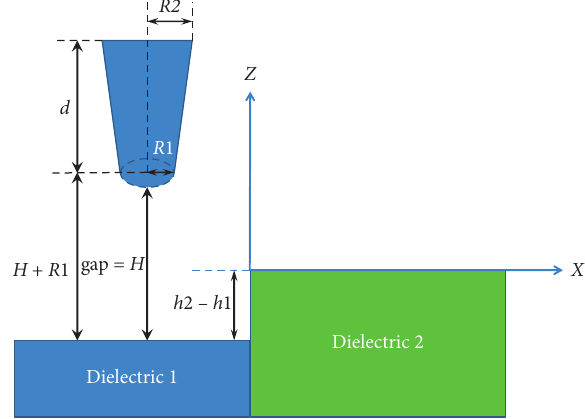
Figure 7: Schematic diagram of near-field probe scanning with sample surfaces of different structures and the probe scanning along the x